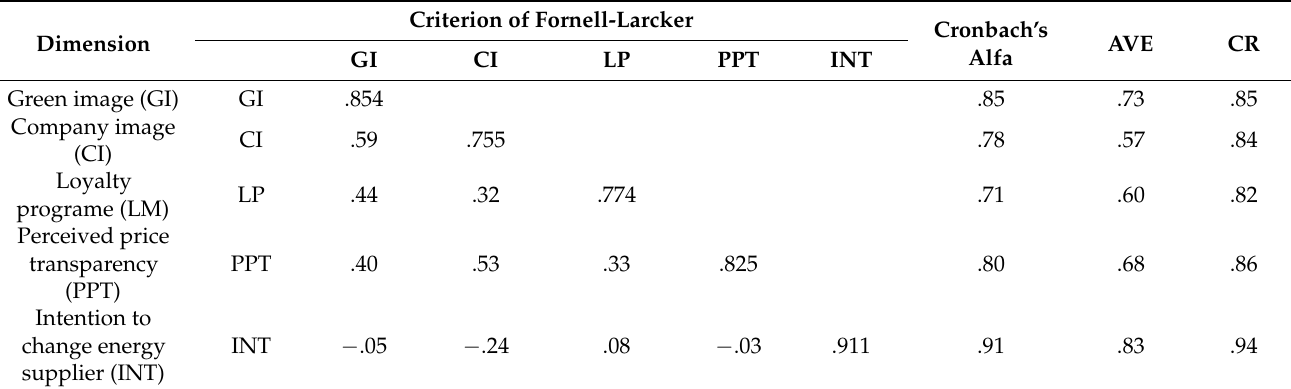
Table 3. Selected measures of contracts’ reliability and validity.